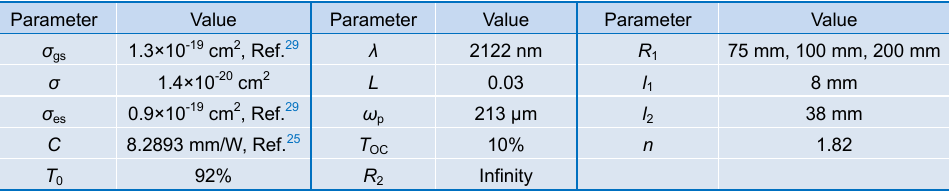
Fig. 2 | ( a , b ) Evolutions in cavity mode sizes ω c and ω s with the absorbed LD power P abs at different M 1 curvature radii ( R 1 =75 mm, 100 mm and 200 mm); ( c ) Evolution in key parameter α with P abs , where the colorful areas denote corresponding unstable regions (green for R 1 =75 mm, blue for R 1 =100 mm), α th is ( n i / n th )/( n i / n th –1) in Equation (1). Values of the parameters for the above calculation are summarized in Table 1. Table 1 | Values of the parameters in Equations (1) –